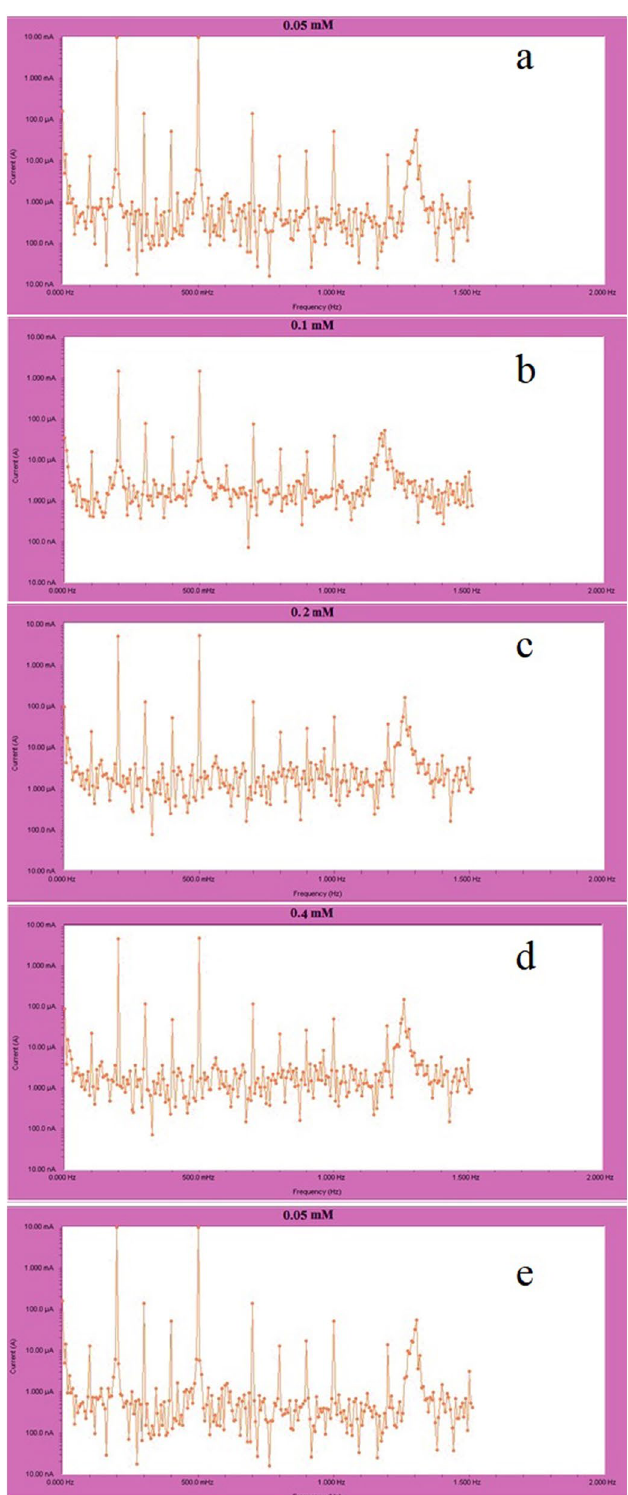
Figure 15. MS intermodulation spectrum in 1 M hydrochloric acid solution with ( a ) 0.05, ( b ) 0.1, ( c ) 0.2, ( d ) 0.4 and ( e ) 0.5 mM nonanedihydrazide at 303